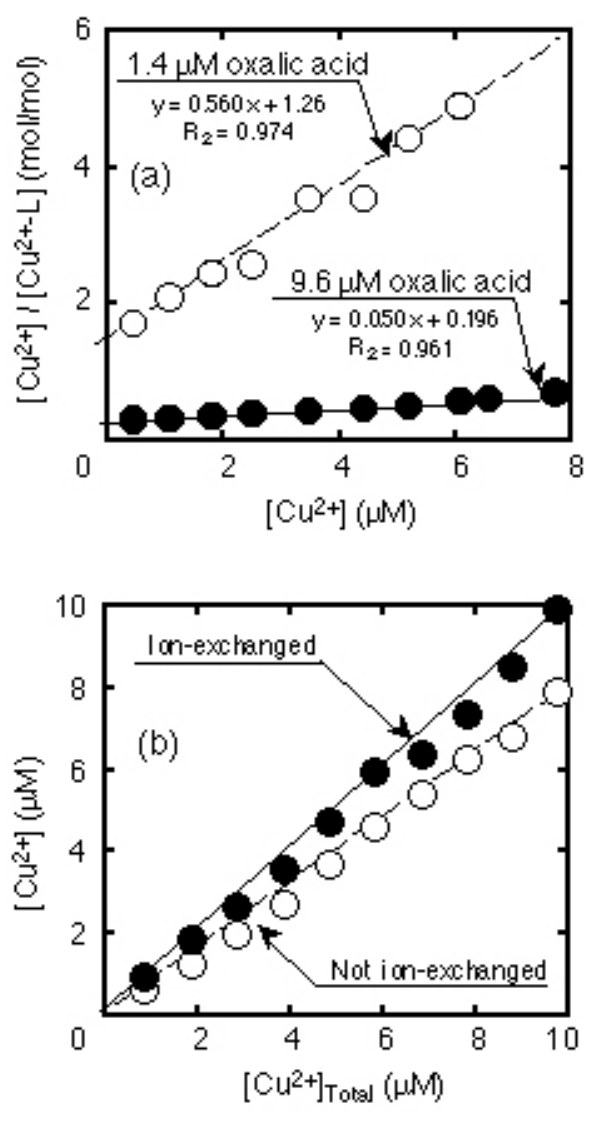
FIGURE 6 . (a) Linearization of 1.4- and 9.6-µM oxalic acid solution using Eq. 13. Ligand concentrations are estimated from the inverse of the slope and stability constant from the y-axis intercept. (b) The relationship between total and free cupric ion concentration in the presence of 0.1-M glyoxal, which was treated with and without Cl-form ion-exchanged column .